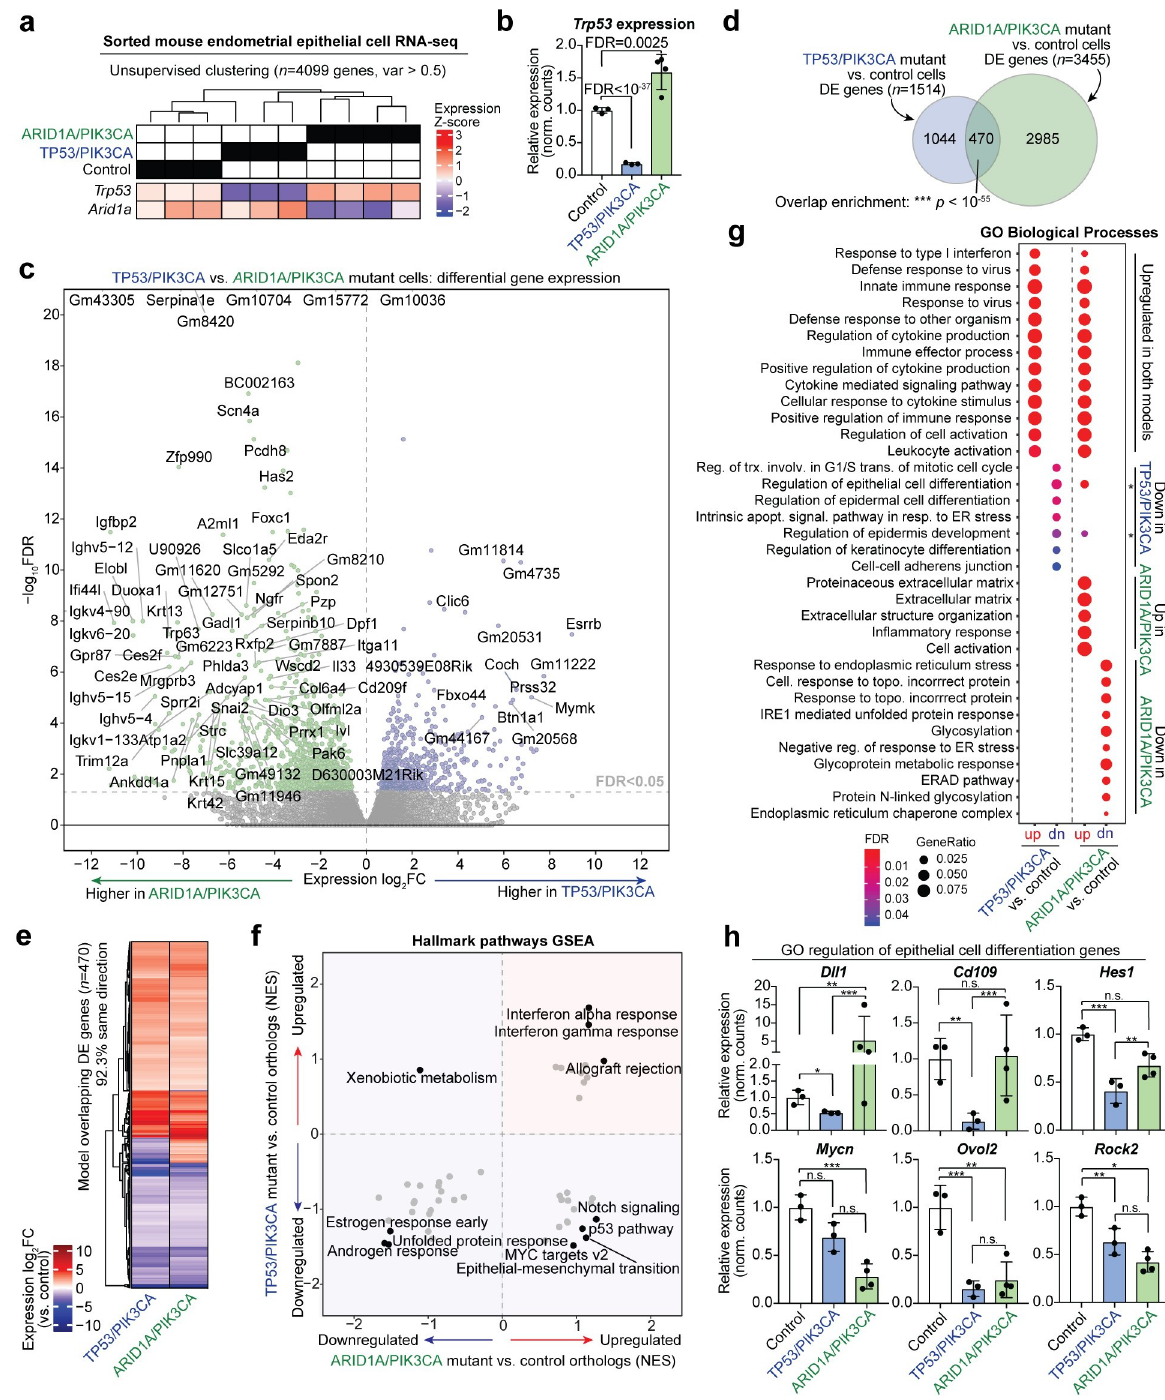
Fig 3. Endometrial epithelial TP53 and ARID1A loss results in overlapping and distinct gene expression programs. a , Unsupervised hierarchical clustering of gene-level RNA-seq data from sorted endometrial epithelial cells of TP53/PIK3CA mutant mice compared to ARID1A/ PIK3CA mutant and control cells. Relative Z-score expression of targeted genes are displayed below clustering result. b , Relative linear Trp53 expression in endometrial epithelial cell transcriptomes. c , Volcano plot depicting differential gene expression between TP53/PIK3CA mutant and ARID1A/PIK3CA mutant cells. d , Overlap of DE genes between TP53/PIK3CA mutants and ARID1A/PIK3CA mutant cells vs. controls. Statistic is hypergeometric enrichment. e , Heatmap of 470 shared dysregulated genes in endometrial epithelial cells from each genetic model. 92.3% of intersecting DE genes are affected in the same direction. f , Overview of Broad GSEA results for MSigDB Hallmark pathways in endometrial